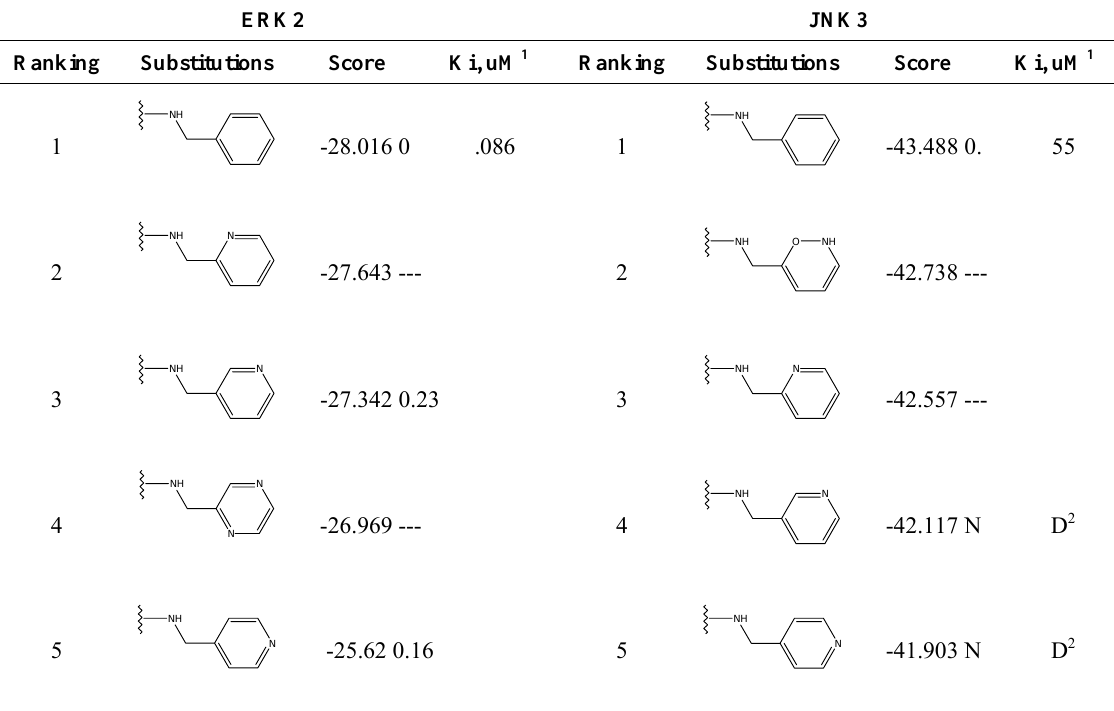
Table 4. Five best scoring substitutions for the complexes ERK2 and JNK3 kinases with A33. ERK2 JNK3 Ranking Substitutions Score Ki, uM 1